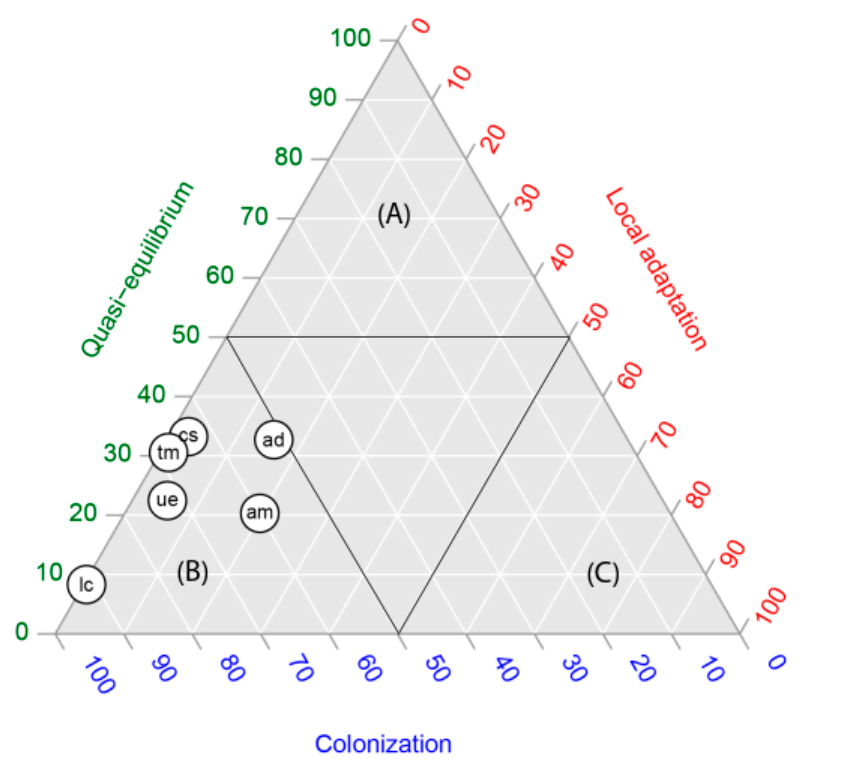
Figure 2. Ternary plot of the proportional area covered by each invasive stage (the geographic space), depicting the relative position of six alien leguminous species: Acacia dealbata (ad) , A melanoxylon ( am) , Cytisus striatus ( cs) , Teline monpessulana ( tm) , Ulex europaeus ( ue) and Lotus corniculatus (lc), central Chile, in relation to quasi-equilibrium, local adaptation and colonization stages. Capital letters represent zones dominated by quasi-equilibrium ( A ), colonization ( B ) and local adaptation ( C ).